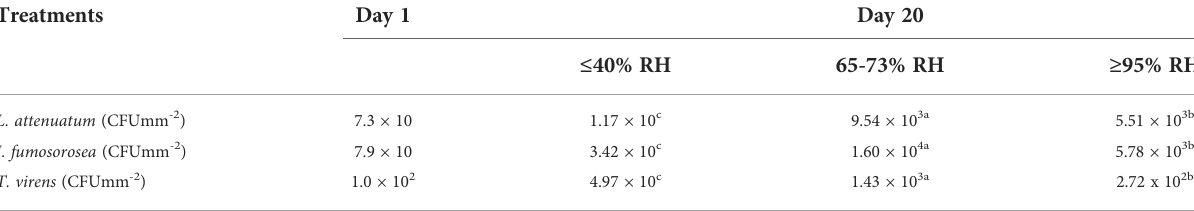
TABLE 2 The mean CFU of fungi isolates found per unit area (mm 2 ) of leaf discs of cucumber leaves treated with biological agents, Lecanicillium attenuatum (LLA), Trichoderma virens (TVI), and Isaria fumosorosea (IFR).